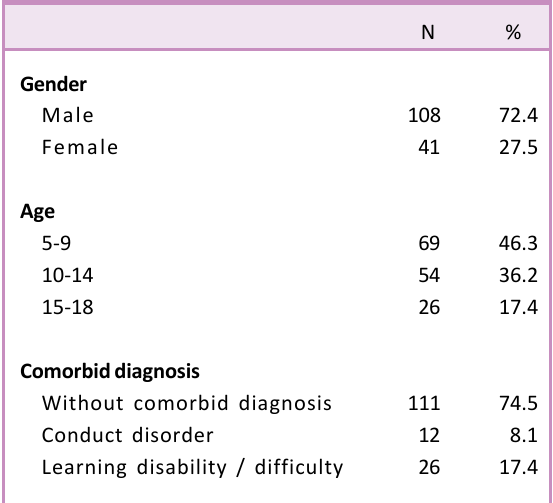
Table 1. Demographic and clinical characteristics of participants